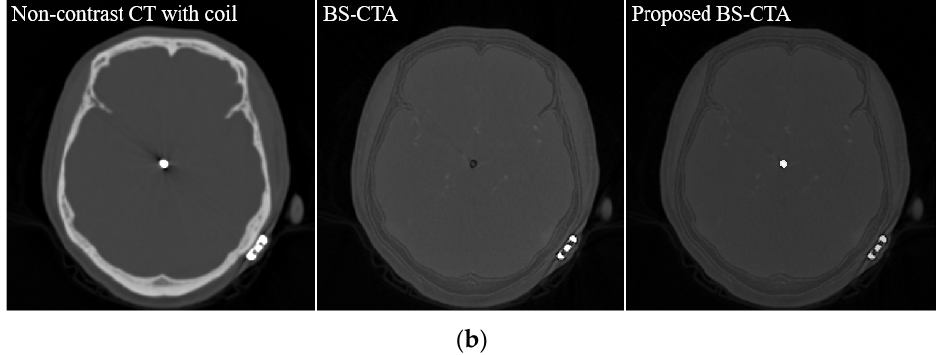
Figure 7. Results of non-contrast CT ( left ), BS-CTA ( middle ), and the proposed BS-CTA ( right ); ( a ) the two-clip case and ( b ) the coil case.